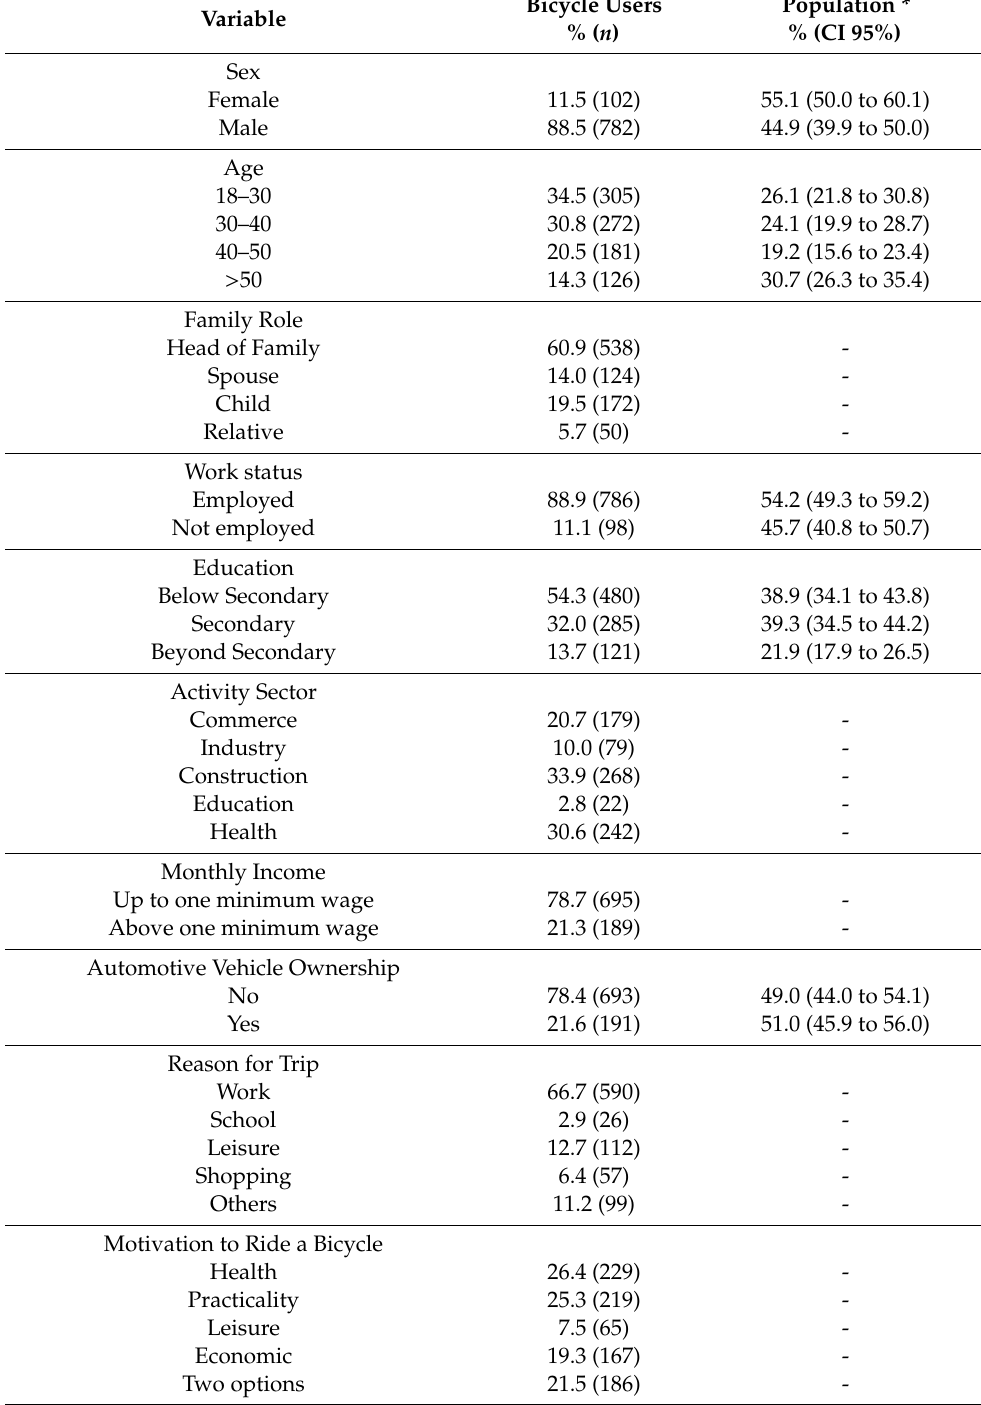
Table 1. Characteristics of Bicycle Users and Aracaju’s